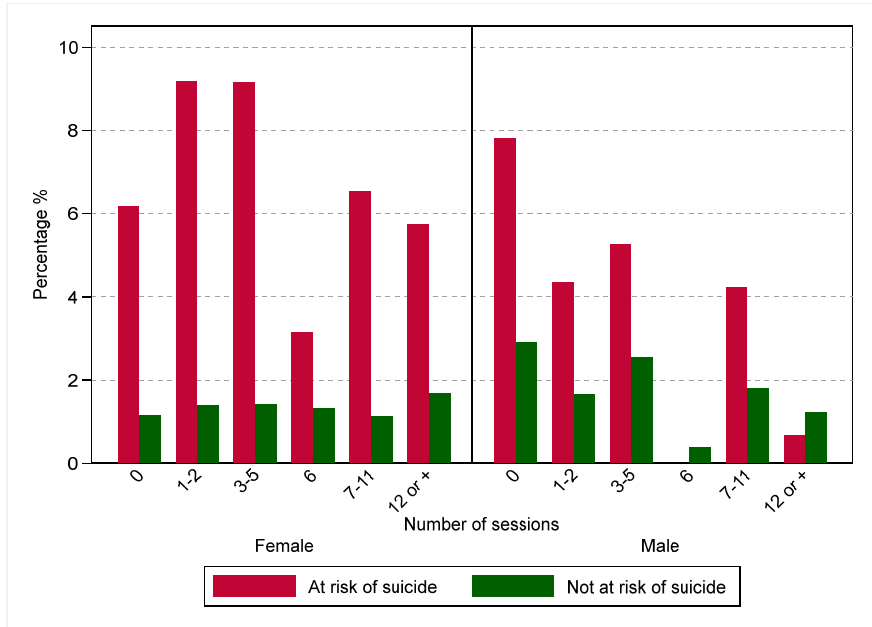
Figure 3. Hospital-treated self-harm within 12 months after the last service contact date by number